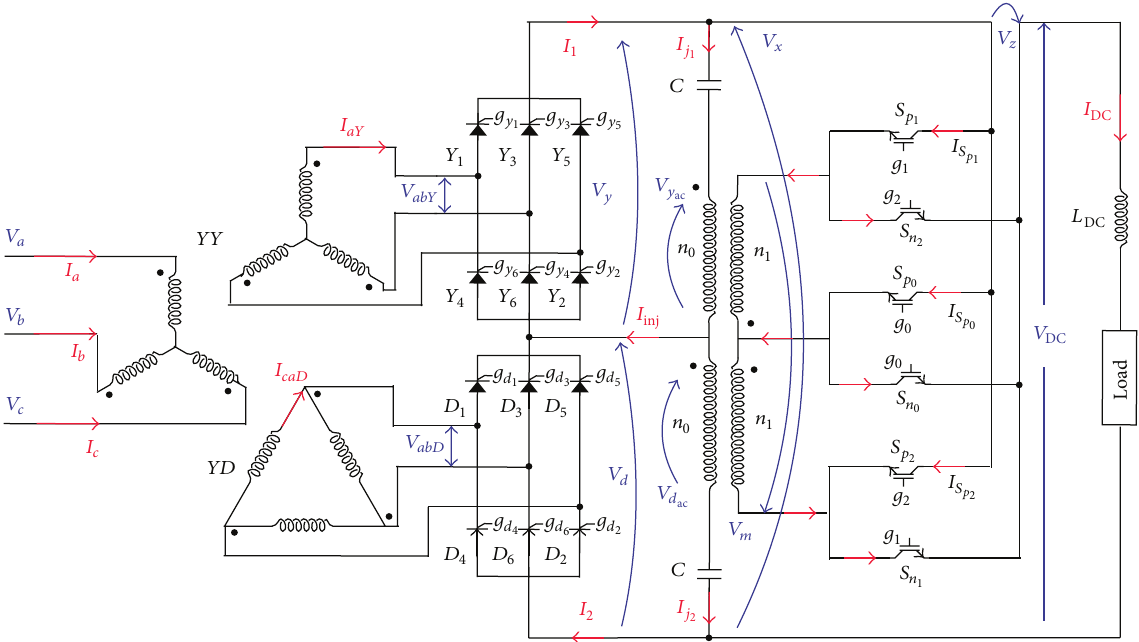
Figure 1: Three-level thyristor based MLCR CSC with Linear